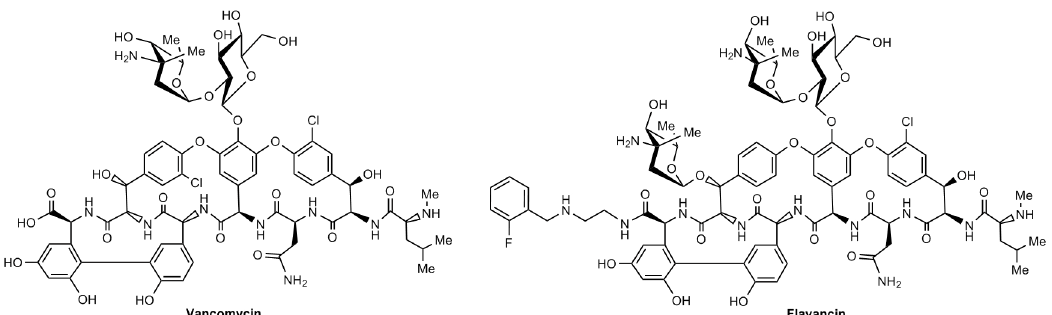
Figure 1. Chemical structure of vancomycin and flavancin.